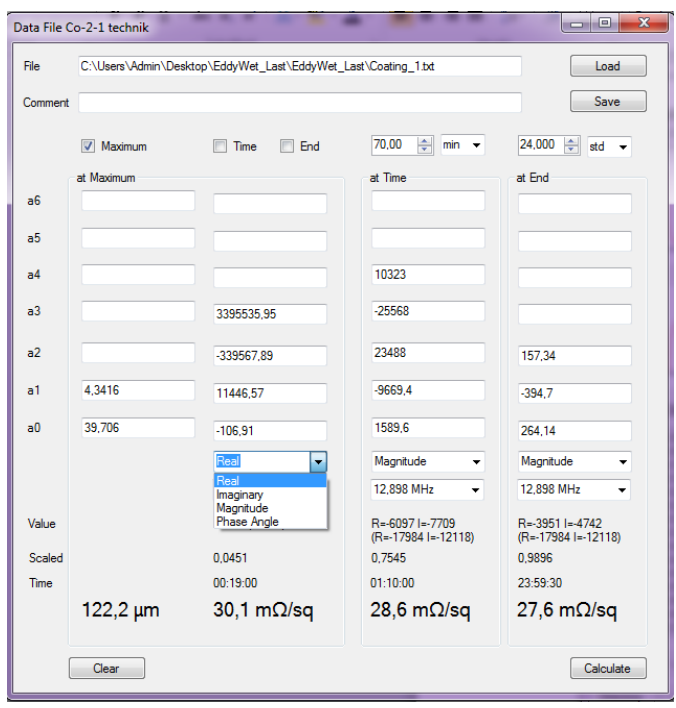
Figure 18. Screenshot of the “Resistivity” menu.